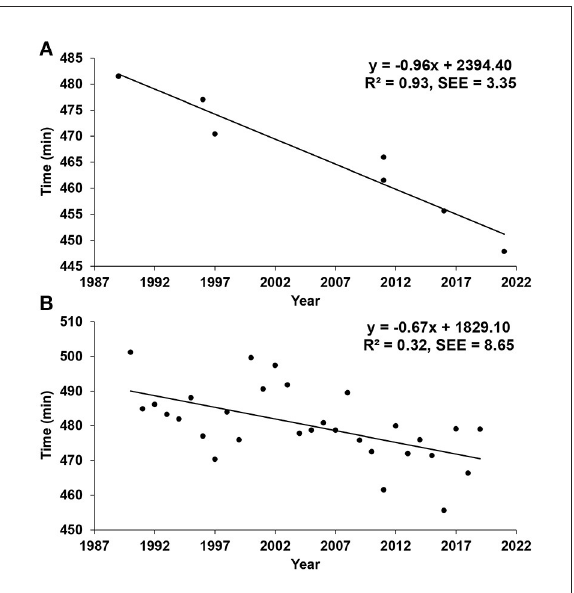
FIGURE1 (A) Prediction of the best Ironman TM finishing time from the best times achieved over the distance from 1989 to 2021. (B) Prediction of the best Ironman TM finishing time from the best times achieved each year over the distance during IM Challenge Roth from 1990 to 2019. SEE, standard error of the